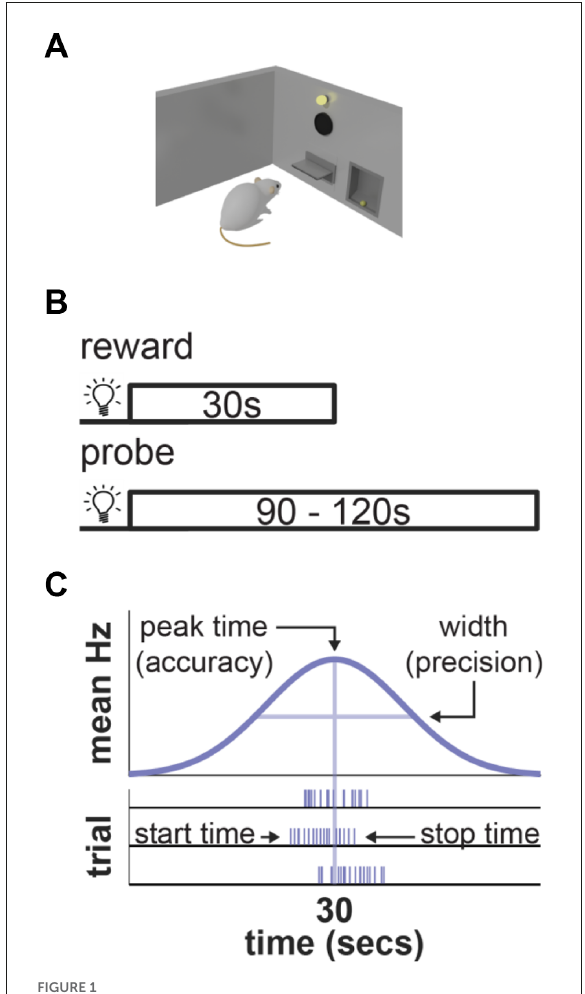
FIGURE1 Peak-interval procedure. (A) Illustration of task equipment. (B) Task-design diagram. (C) Illustration of ideal behavior during probe trials with respect to mean response rates (top) and single- trials